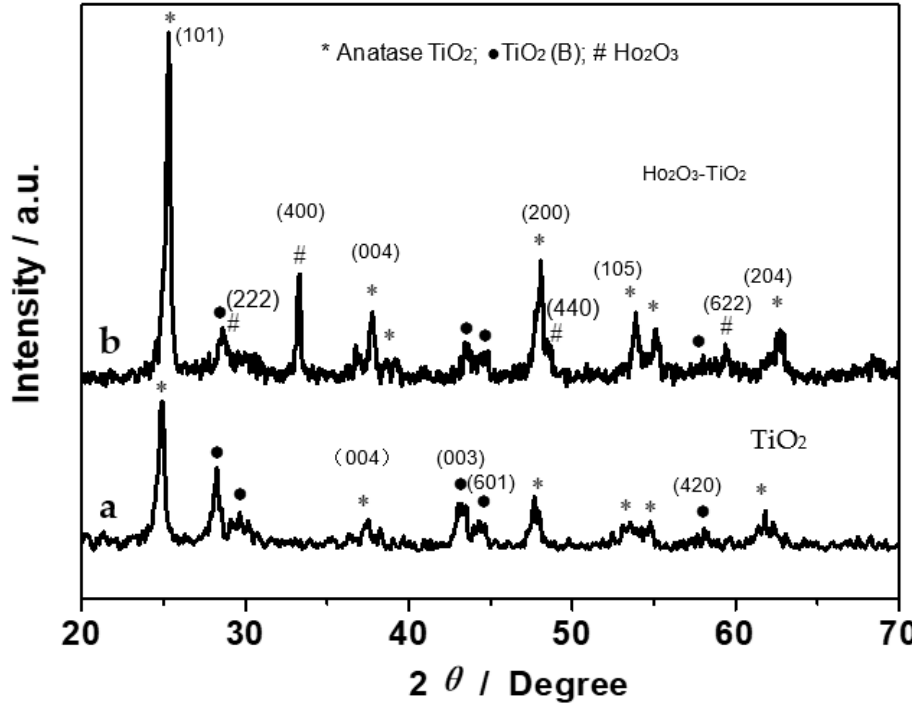
Figure 1. XRD patterns of (a) TiO 2 and (b) Ho 2 O 3 -TiO 2 nanobelts.